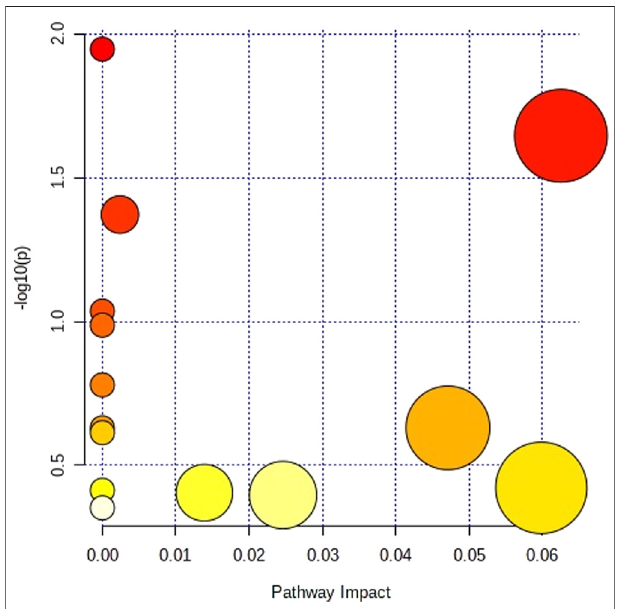
FIGURE 5 | Metabolic pathway analysis with the MetaboAnalyst.